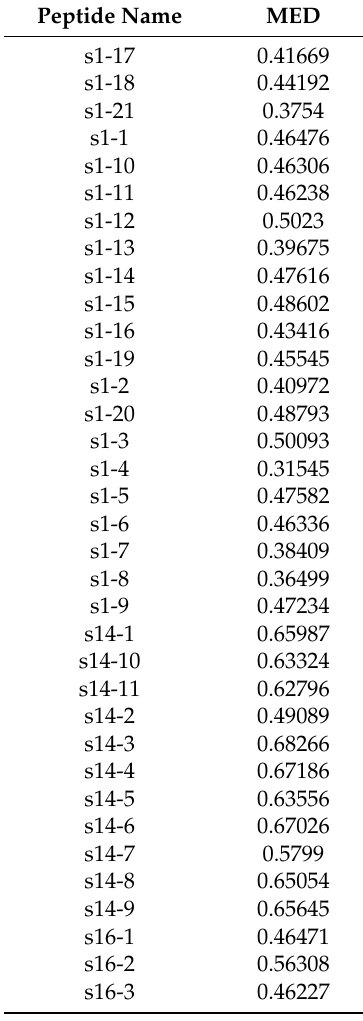
Table 1. The names of the different conformations of peptides generated by MOE software and the corresponding values of their MED. Larger numbers correspond to a more closed (longer) peptide conformation.